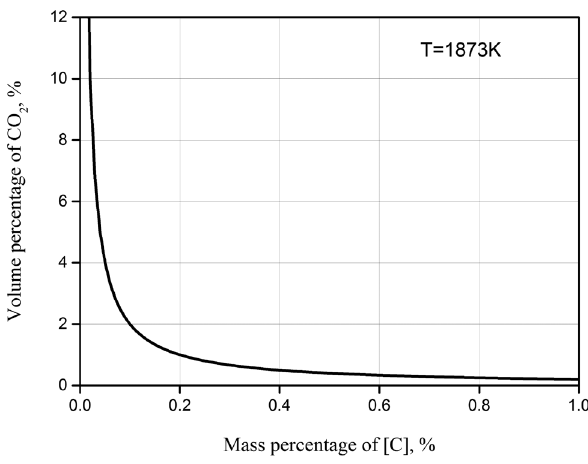
Fig. 1: Relationship between CO 2 in decarburization products and [C]